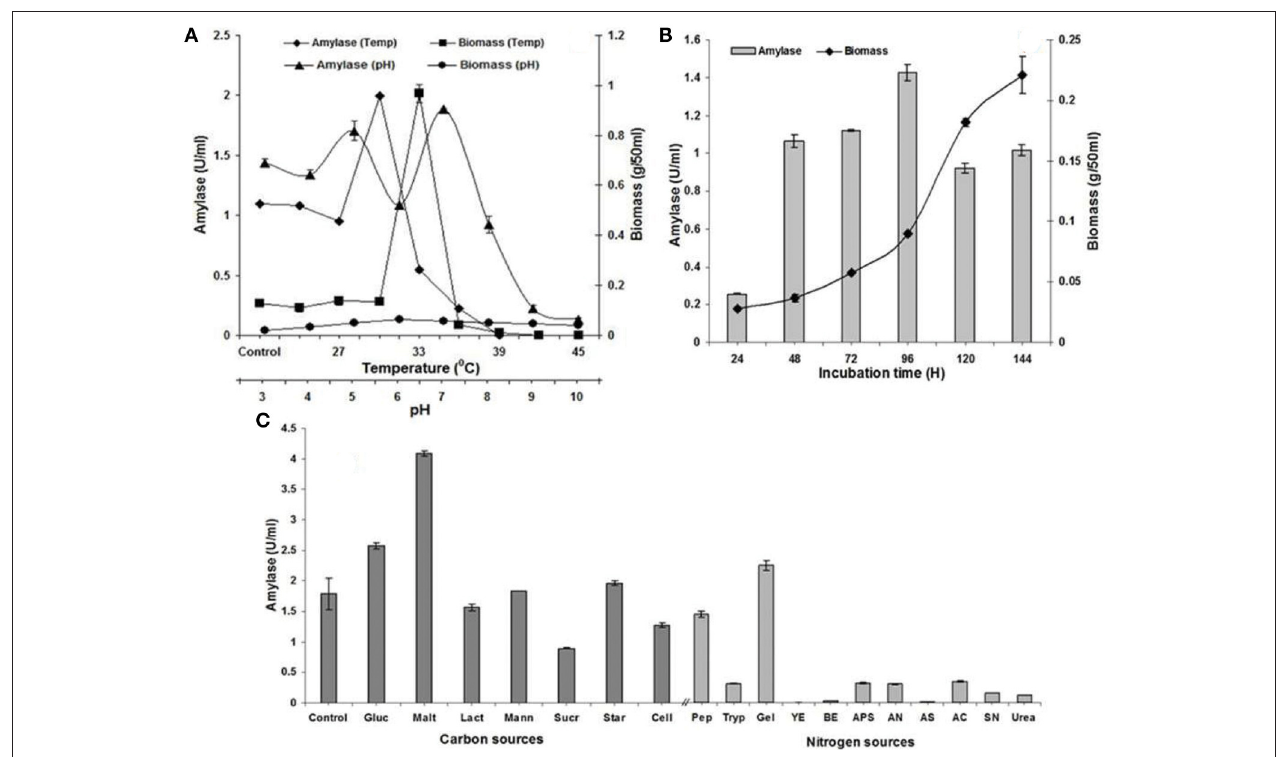
FIGURE 1 | (A) Effect of pH (3.0–10.0) and temperature (24–45 ◦ C at 3 ◦ C interval) on amylase production and mycelia growth in liquid static surface culture (LSSF) by A. terreus NCFT 4269.10 after 96 h of cultivation; (B) Influence of incubation time on amylase production and mycelia growth during liquid static surface culture by